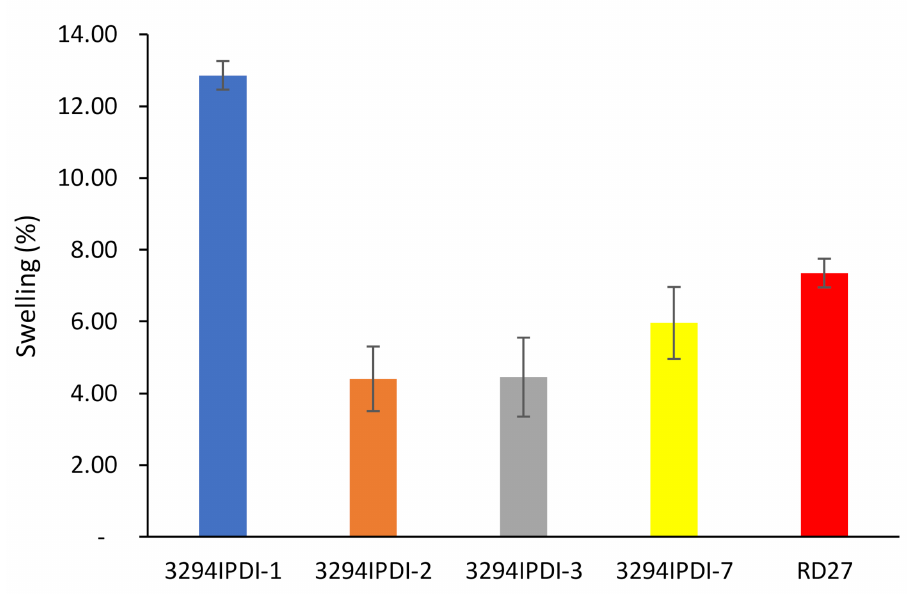
Figure 15. Swelling of WPUD films in water at 25 ◦ C for 48 h. The swelling values of the films after 48 h are consistent with the increased content of hydrophilic chain extender (DMBA), in agreement with the behavior that was reported by Xu et al. for dimethylol propionic acid (DMPA) [35]. Although the DMBA content seems to be the determining factor in the water absorption of the films, the increasing content of Priplast 3294 (hydrophobic polyol soft segment) also has a notable influence in decreasing water swelling, as can be noted in contour plot from Figure 16